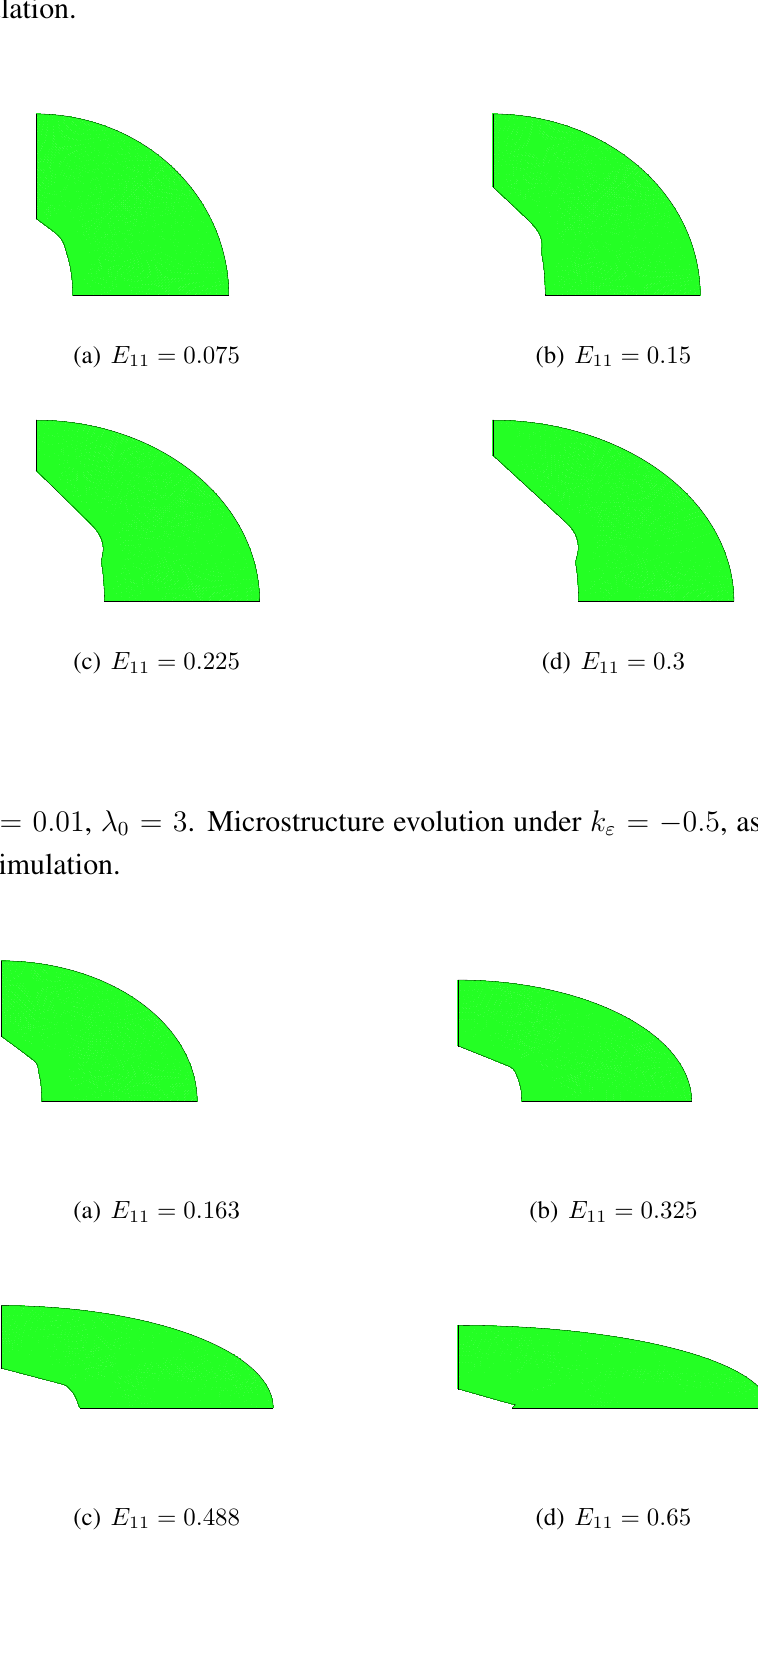
= 0 . 0 , as obtained with the ε